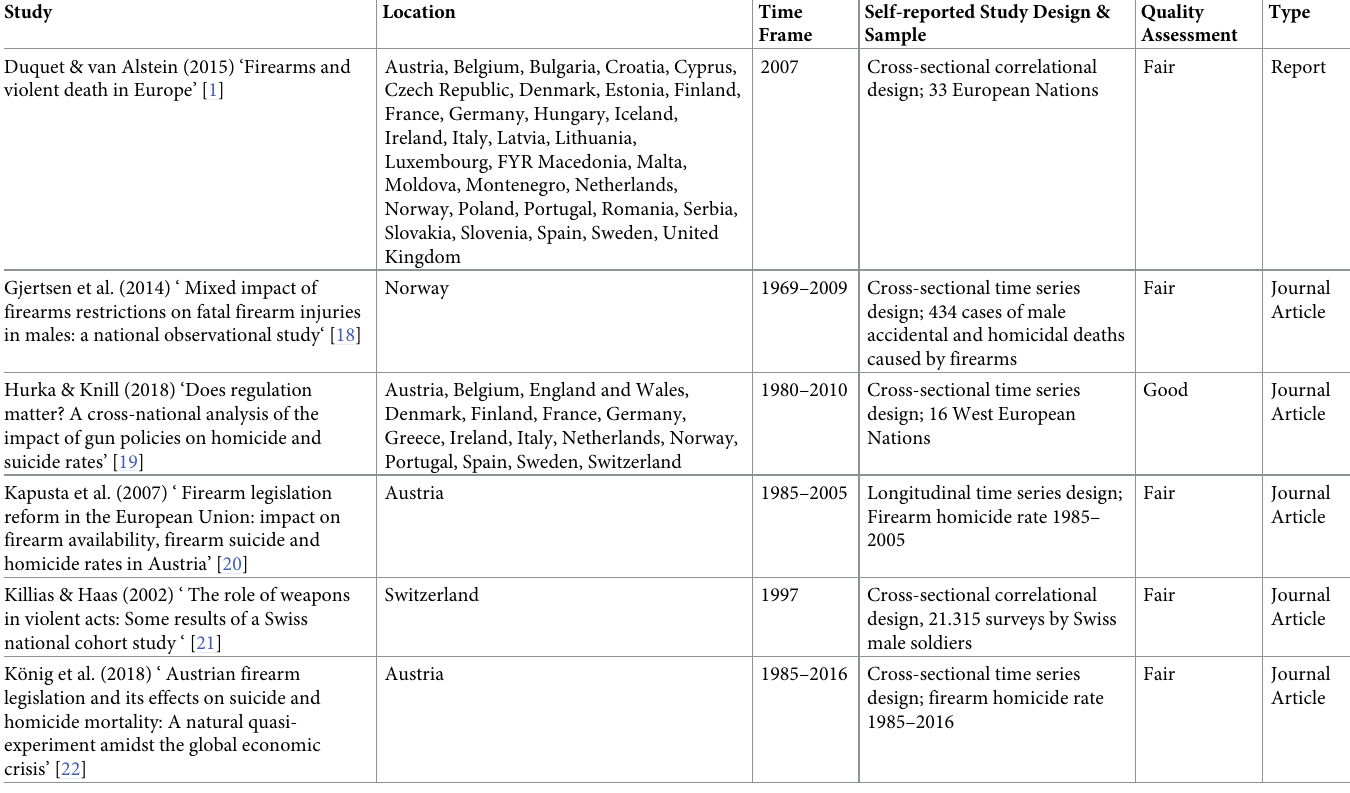
Table 1. Characteristics of included studies, including study locations, time frame studied, study design, sample, quality and type of study.